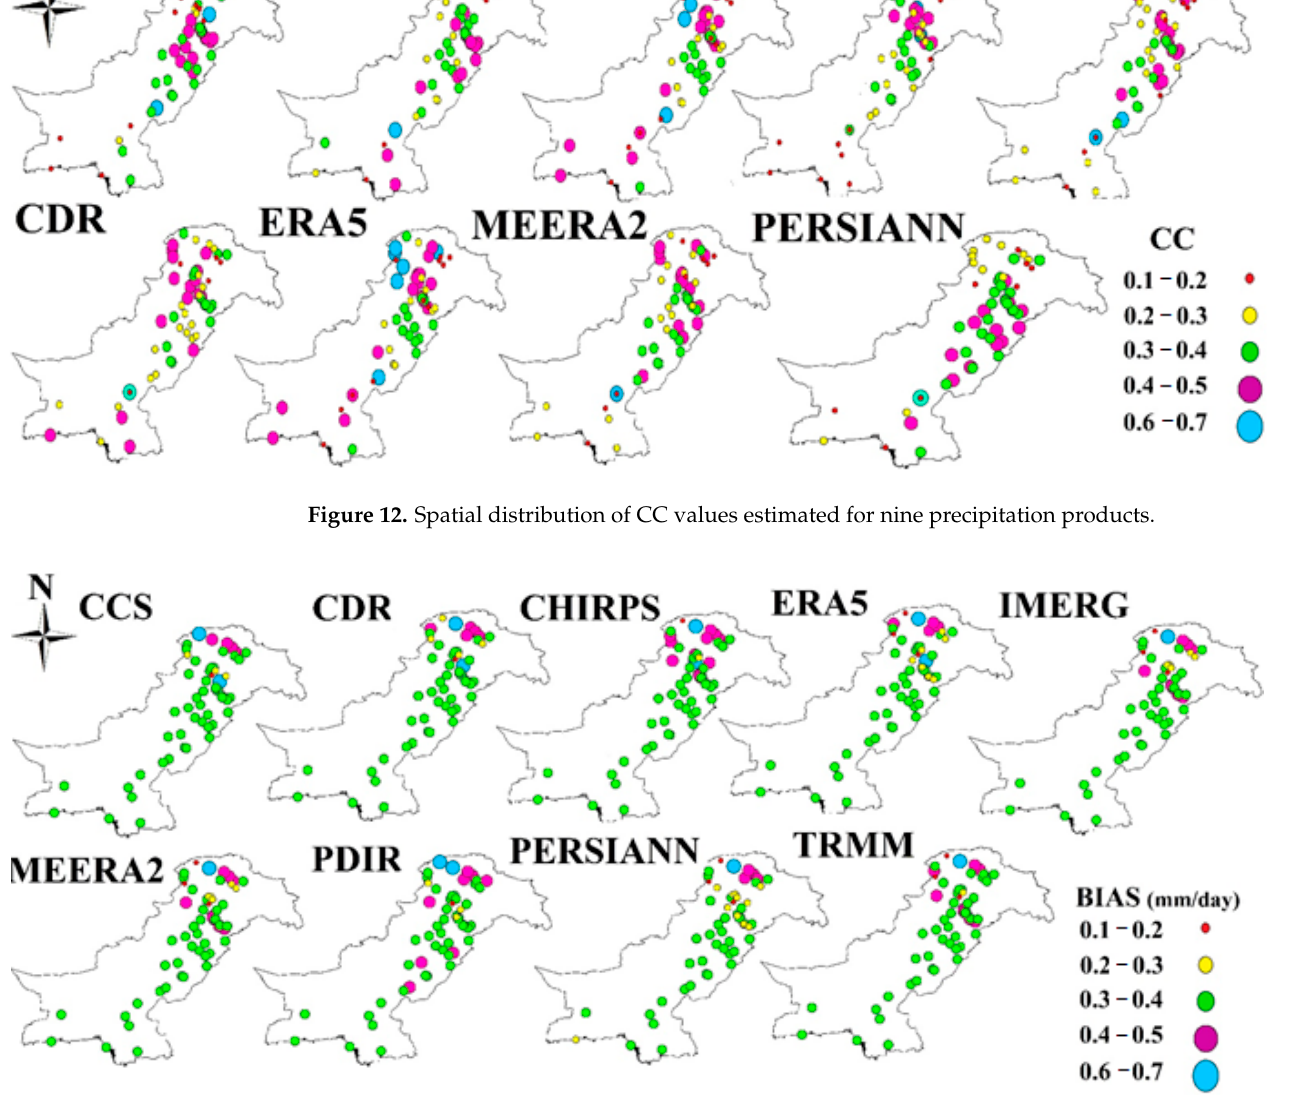
Figure 13. Spatial distribution of bias estimated for nine precipitation products in Pakistan.